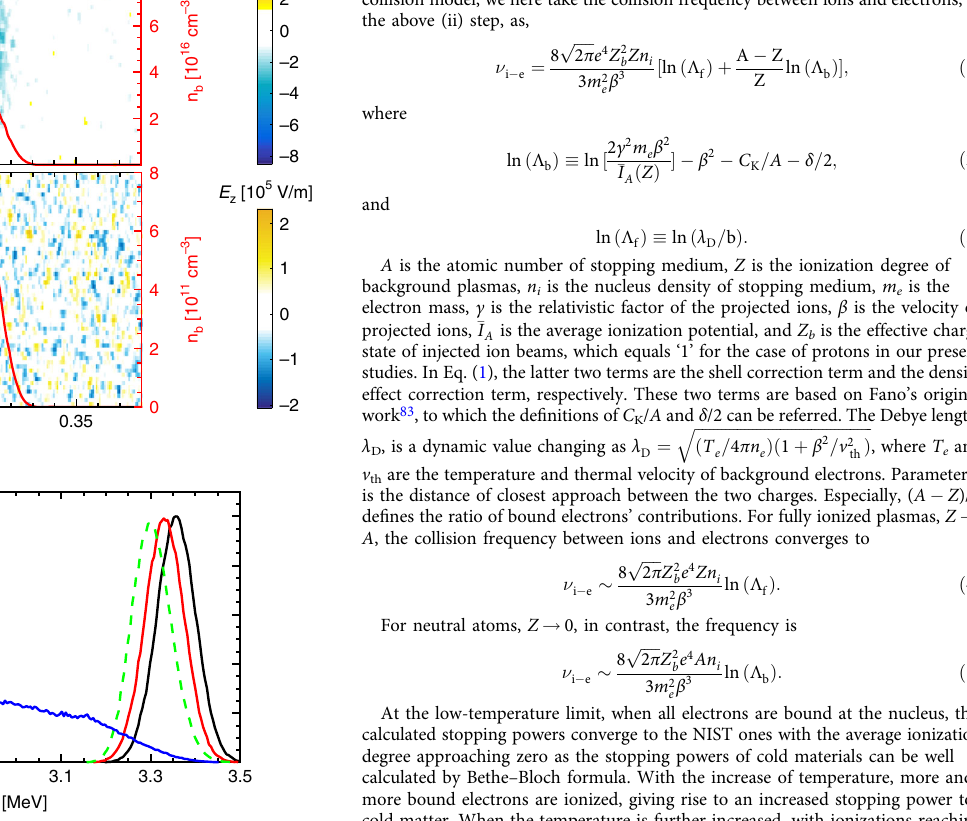
Fig. 4 Simulated distribution of longitudinal electric fi eld and proton beam density during beam transport in experimentally used ionized target, and the resulting proton beam energy spectra shift after passing through the sample. a Longitudinal electric fi eld driven by proton beam, moving along the Z direction with a beam density of 8 × 10 16 cm − 3 . The beam density pro fi le is indicated by the red solid curve. b The same situation as in ( a ) but the initial beam density is reduced to 8 × 10 11 cm − 3 . c Normalized energy spectra. The energy spectra of protons without target are represented by the black solid curve. The colored lines indicate the energy spectra of protons passing through the plasma target for varying beam densities of 8 × 10 11 cm − 3 (red solid line), 8 × 10 15 cm − 3 (green dashed line), and 8 × 10 16 cm − 3 (blue solid